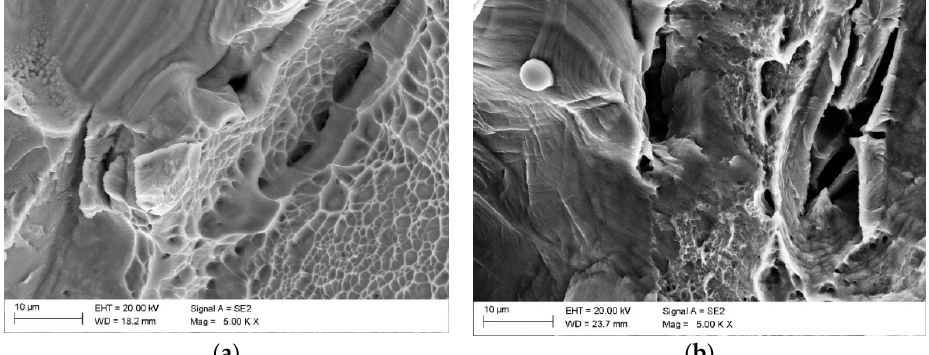
Figure 21. The fracture’s structure of the Ti6Al4V Ti solid 4 alloy after static testing: ( a ) tensile and ( b ) bending.